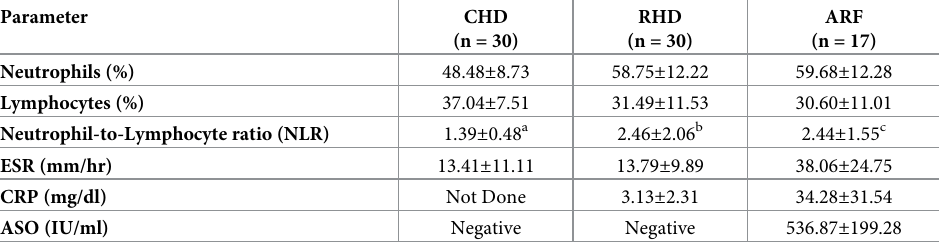
Table 2. Laboratory parameters of the study population * .